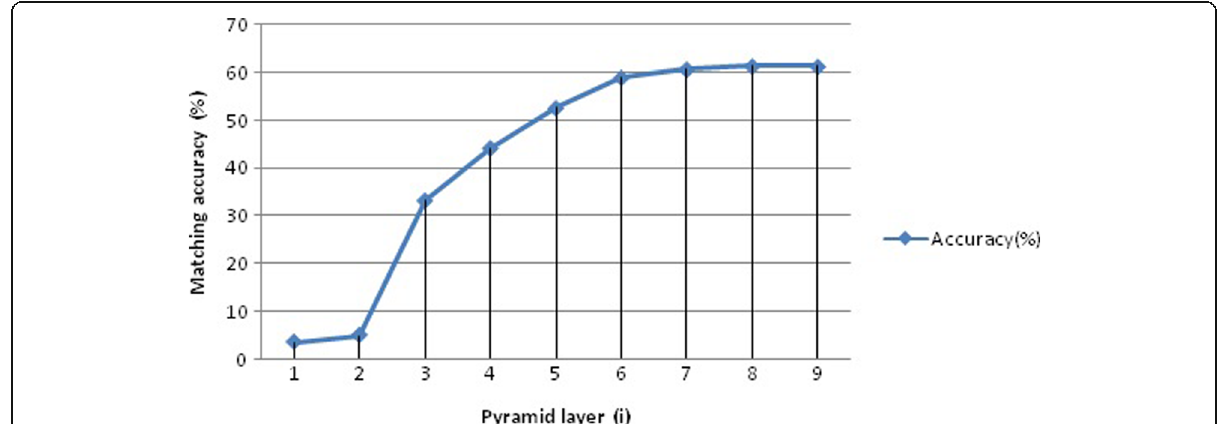
Fig. 30 Relationship between pyramid layer number change and matching accuracy